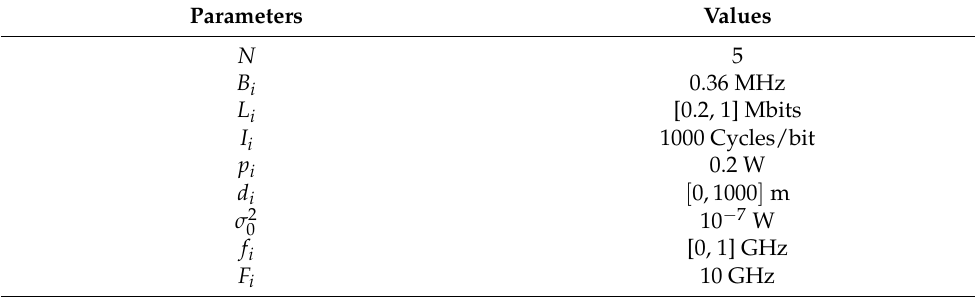
Table 2. Parameter